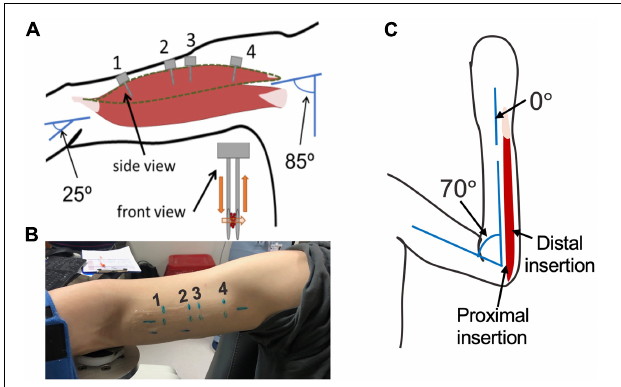
FIGURE 3 | (A) schematic of arm position and location of probe insertion in the long head of the Biceps Brachii. Illustration of probe showing the direction of laser light and interaction with muscle tissue (orange). (B) Picture of location of four probe insertions in one of the study participants. (C) Schematic of the elbow and wrist position and locations of the probe insertion in the flexor carpi ulnaris.